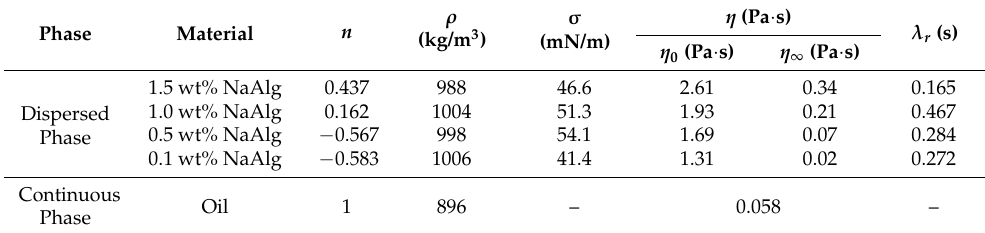
Table 1. The physical properties of two-phase flow (room temperature 25 ºC).